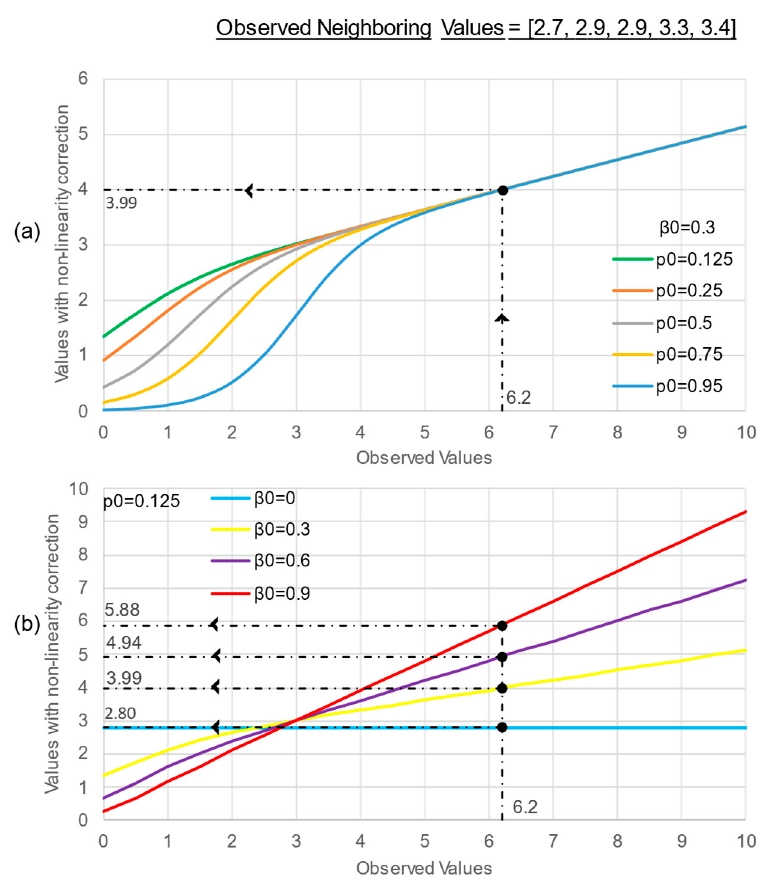
Figure 8. Effect of the nonlinear estimator on the observed value as the p_0 ( a ) and the β _0 parameter ( b ) change; the case of observed value equal to 6.2 is highlighted.